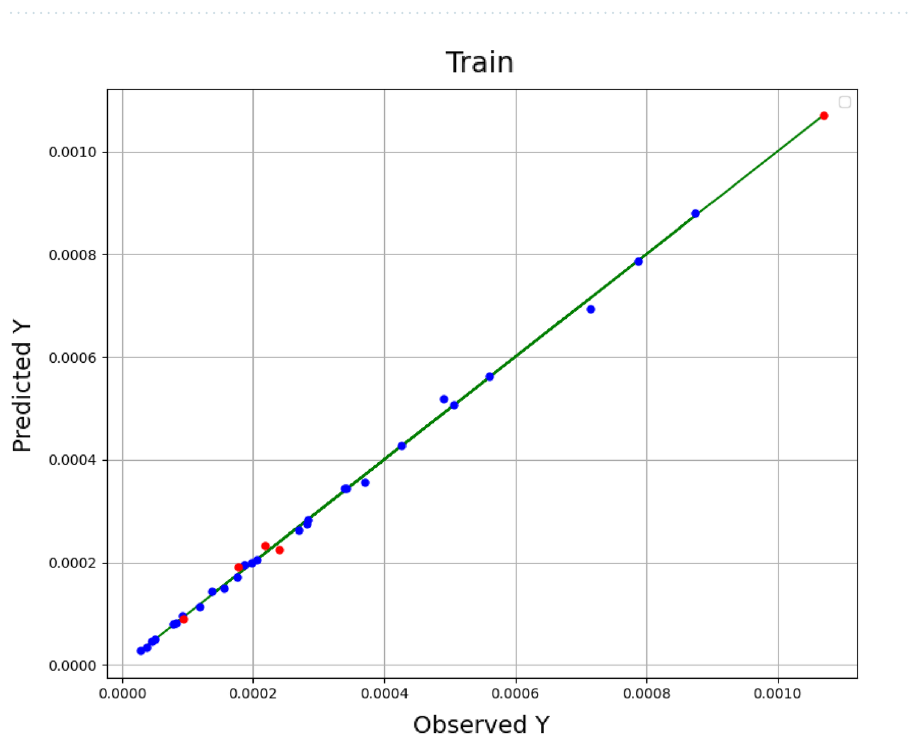
Figure 3. Observed vs predicted values (GPR) (Y: solubility/mole